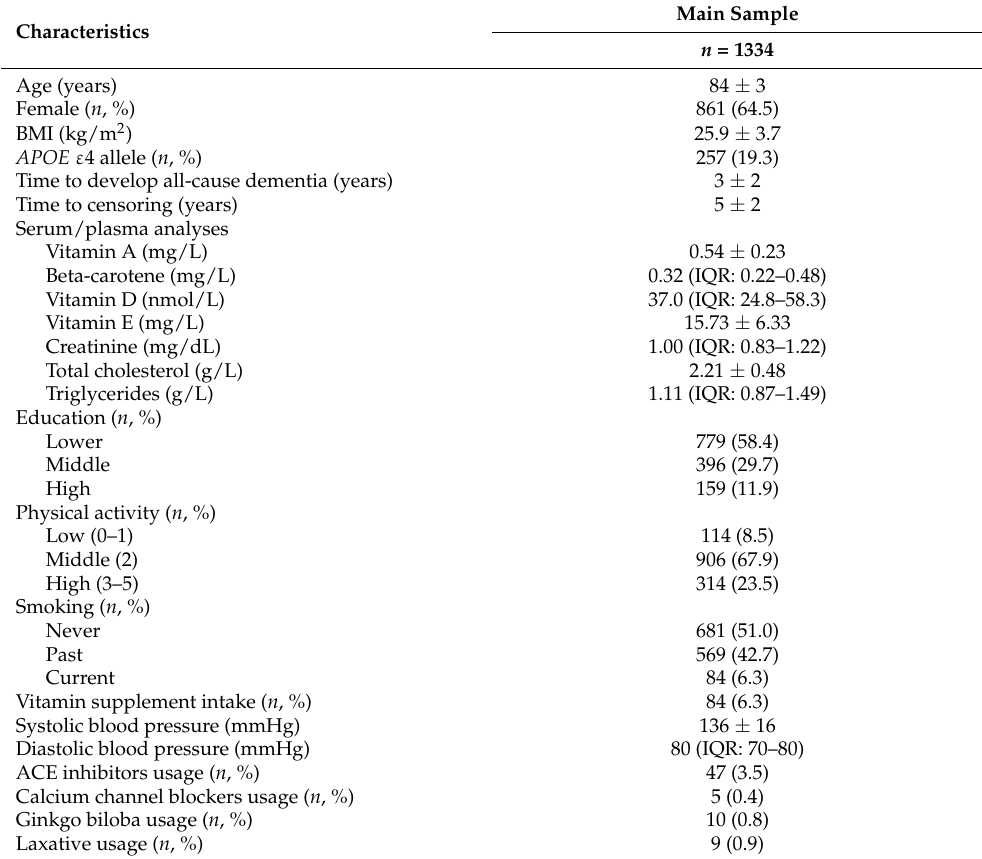
Table 1. Characteristics of study